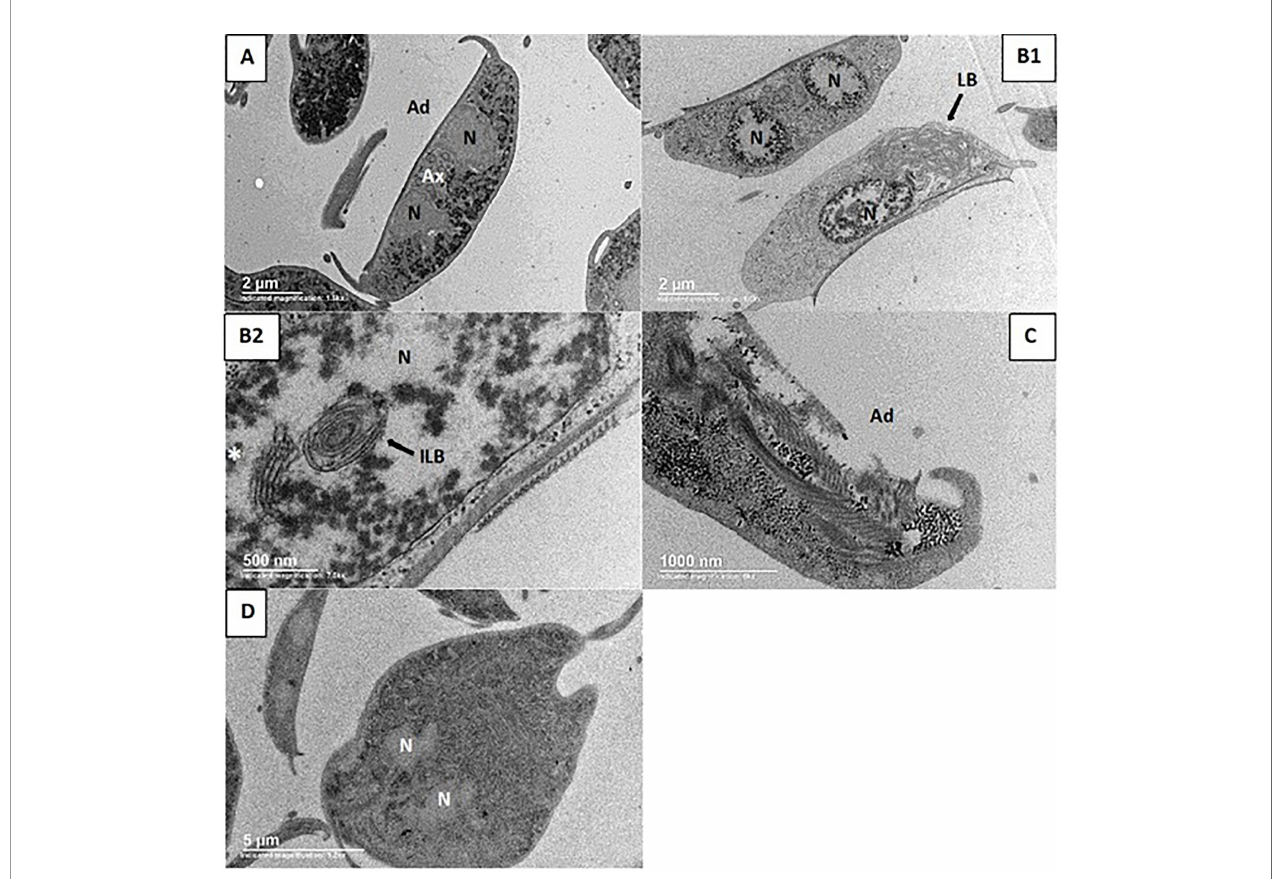
FIGURE 2 | Transmission electron micrographs from G. lamblia trophozoites. (A) Control of trophozoite. (B1, B2) Trophozoites treated with EHV-110-174; in (B1) : Trophozoite with its condensed chromatin distributed in the nucleus periphery, the other trophozoite containing a huge lamellar body (LB) covering almost half of the cell. (B2) : Close-up image; the nucleus has condensed chromatin and contains an intranuclear LB (ILB) and a cistern-like structure (white asterisk). (C) Albendazole- treated trophozoite exhibiting loss of adhesive disc. (D) Metronidazole-treated trophozoite without apparent morphologic changes. N, nucleus; Ax, axonemes; Ad, adhesive